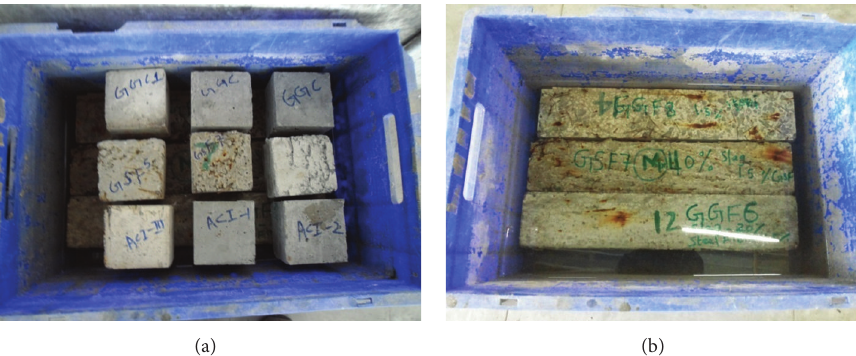
Figure 2: (a) Cube specimens cured in NaCl (3%) solution. (b) Beam specimens cured in NaCl (3%) solution.